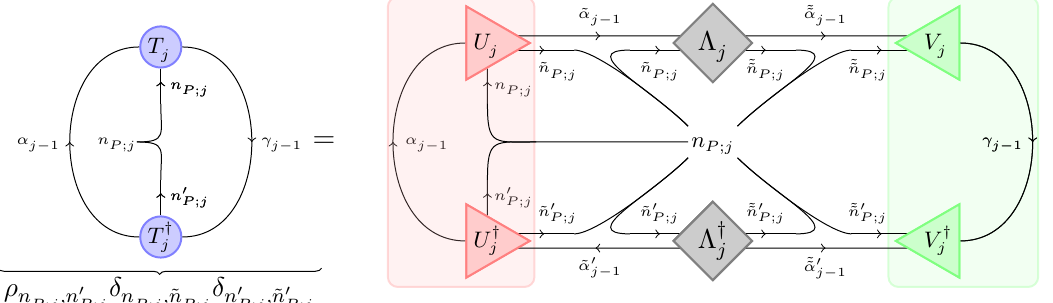
〉 , which by Eq. (52) can be P ; j . P ; j